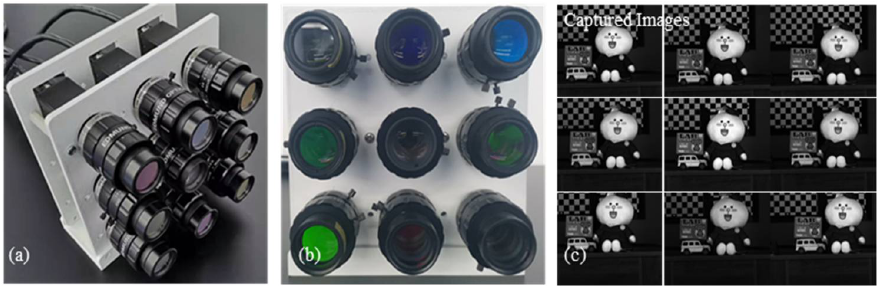
Figure 2. ( a ) Proposed multi-aperture multisystem, ( b ) lens array covered by the notch filter array shown in Figure 1b, and ( c ) images captured by the camera in ( b ) in a single shot.